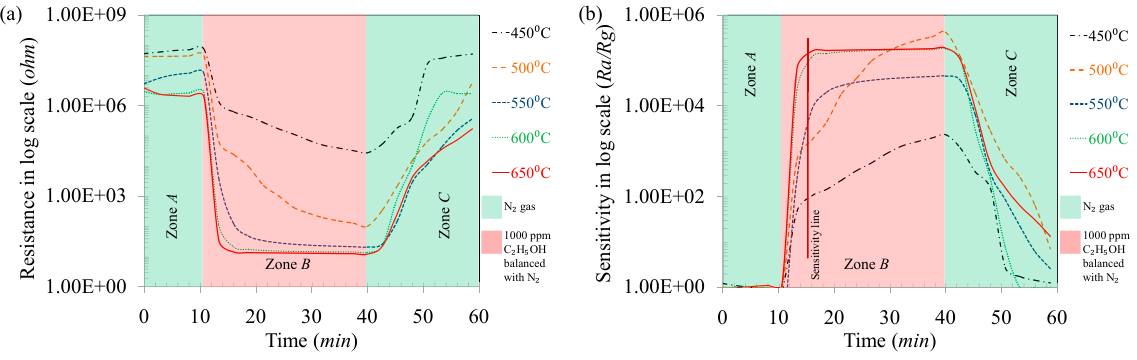
Figure 6. Response of TiO temperatures: ( a ) resistance curves and ( b ) sensitivity